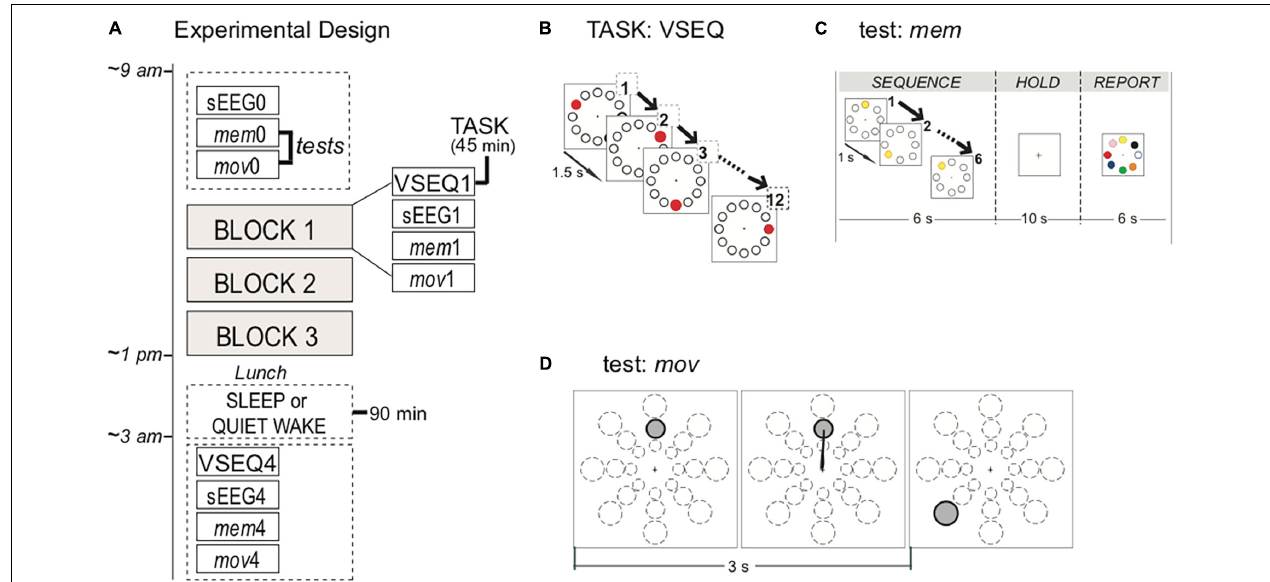
FIGURE 1 | Experimental design, task, and tests. (A) Participants started the experiment at 9 am with baseline recordings of hd-EEG activity during 2 min of spontaneous EEG (sEEG), motor ( mov ) and memory ( mem ) tests. Then, subjects underwent three 45-min blocks of VSEQ task, each followed by sEEG, mov and mem. At the end of the morning, after a lunch break, a subset of subjects took a nap for 90 min, while the others quietly rested for the same amount of time. A further block of was performed 15–30 min after the rest. (B) VSEQ visual sequence learning task in which participants learned 12-element sequences continuously for 45 min. The same sequence was repeated until subjects reached full score. (C) mem is a visual working memory test without learning component. Instructions were to memorize a sequence, to hold it in memory for 10 s and then to report it, before moving to the next one; the test consisted in 16 sequences. (D) mov is a test of reaching movements without adaptation with 24 possible targets located at 4, 7, or 10 cm from the center in eight directions, that randomly appear on the screen every 3